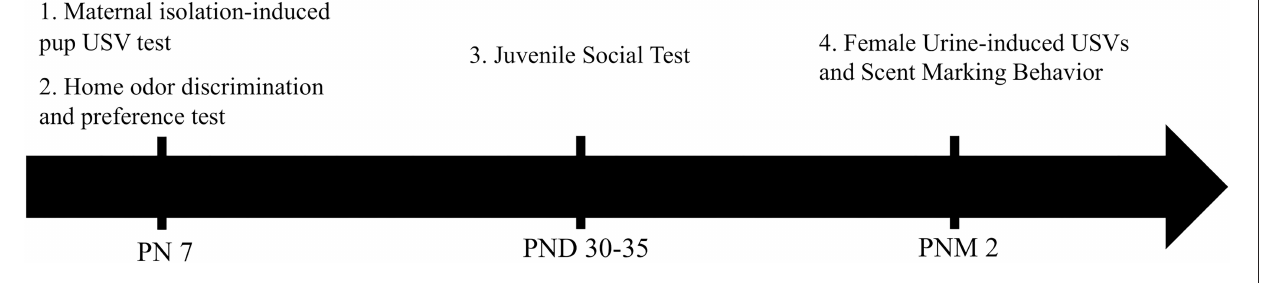
FIGURE 1 | Timeline of the experimental design.